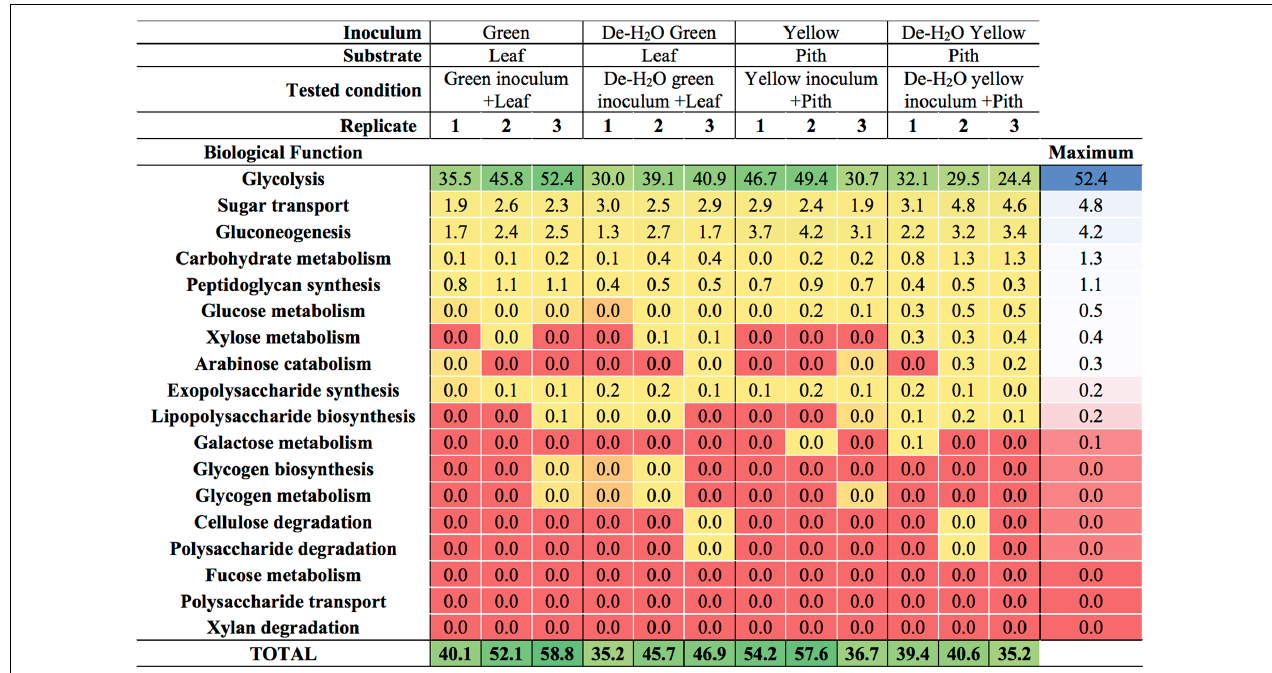
FIGURE 6 | Carbohydrate-related biological functions in laboratory-scale fermentation tests ( n = 3) using microbiomes derived from giant panda fecal samples ( Figure 2 ). Values represent the percentage of total identified microbial metaproteins.